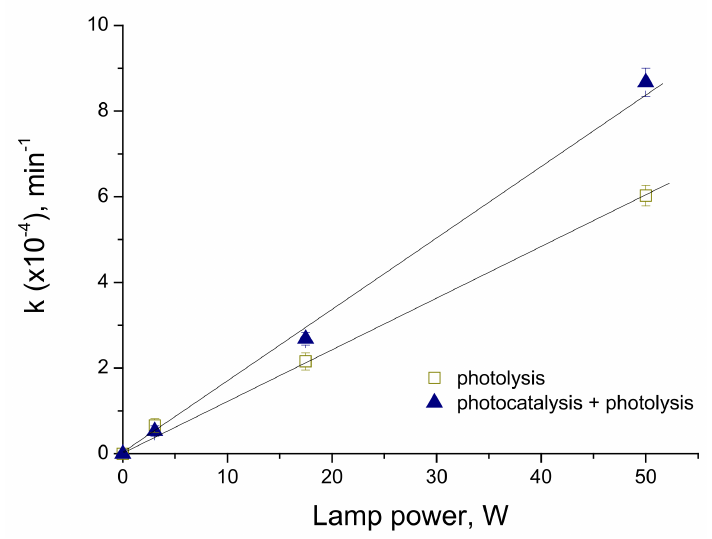
Figure 12. Rate constant of MB decomposition versus visible lamp power ( λ > 385